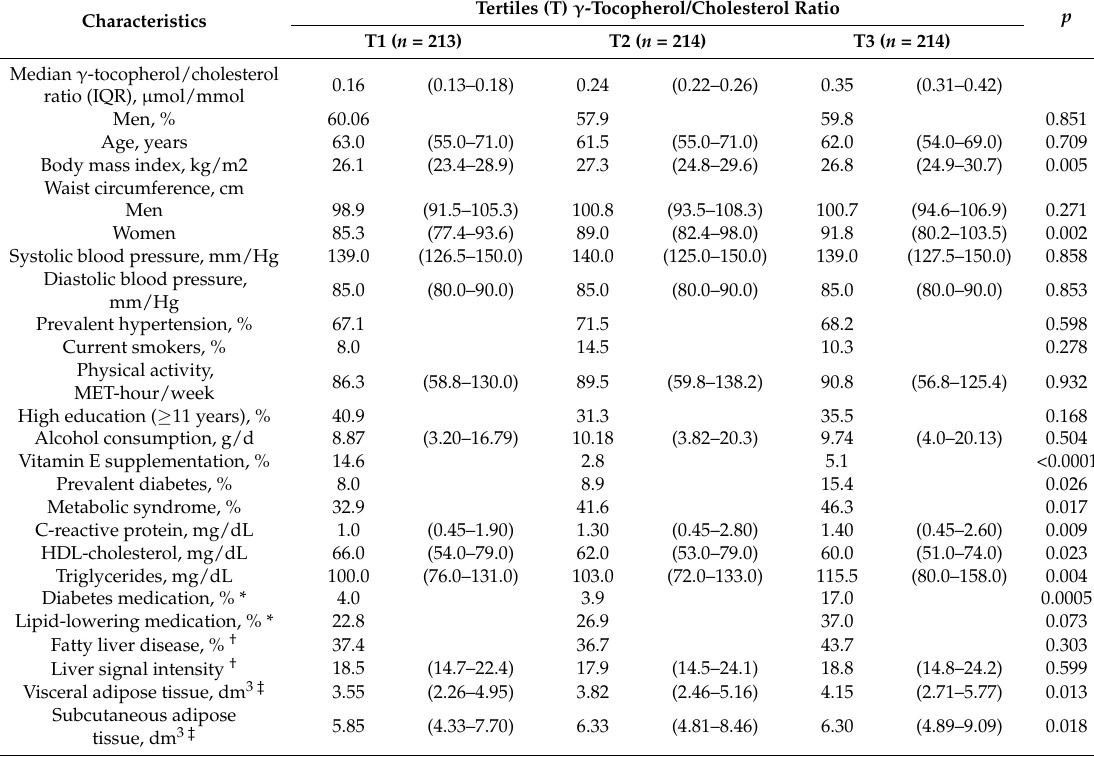
Table 2. General characteristics of the PopGen control study population ( n = 641) according to tertiles of γ -tocopherol/cholesterol